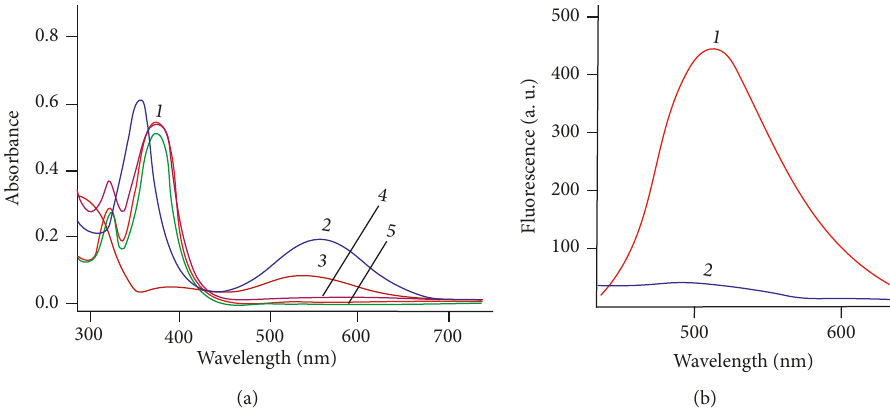
Figure 5: Electronic spectra of 4 in acetonitrile ( 2 0 · 10 − 5 M ). (a) Absorption before ( 1 ) and after addition of F − ( 2 ), CN − ( 3 ), AcO − ( 4 ), and